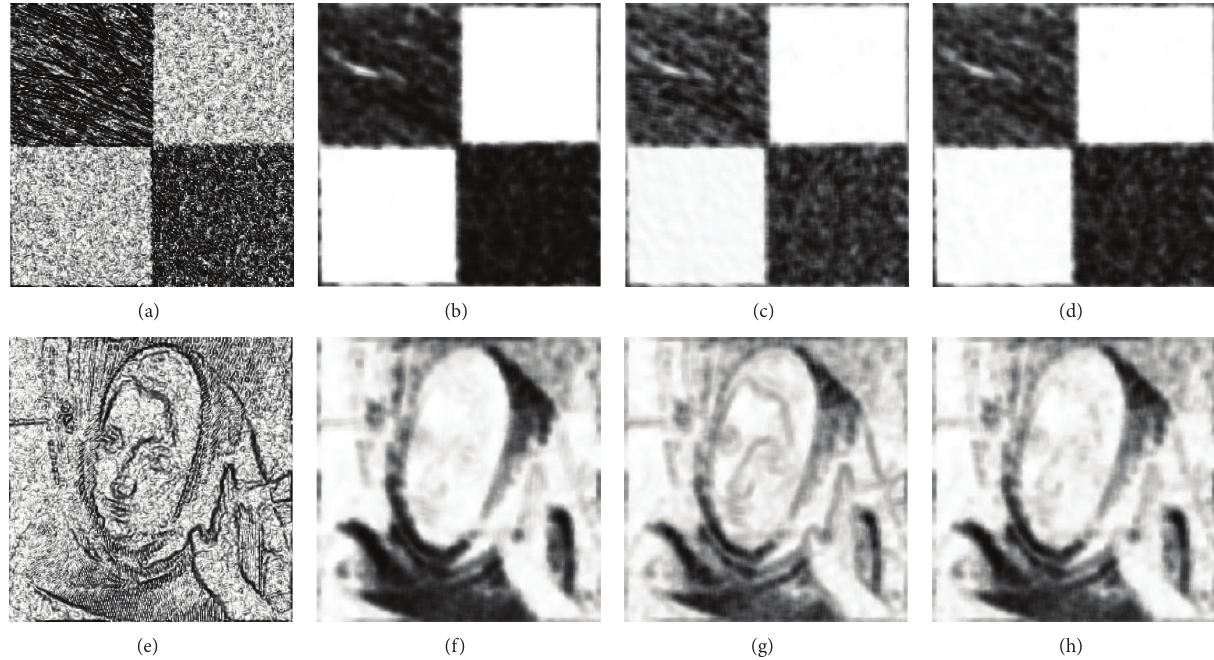
Figure 10: Final values of the regularization parameters in the proposed models and weighting functions in the hybrid model corresponding to Figures 4(d)–4(f) and 6(d)–6(f). (a) 𝑔 in the hybrid model, (b) 𝑔 ∗ in Model 1, (c) 𝑔 ∗ 1 in Model 2, (d) 𝑔 ∗ 2 in Model 2, (e) 𝑔 in the hybrid model, (f) 𝑔 ∗ in Model 1, (g) 𝑔 ∗ 1 in Model 2, and (h) 𝑔 ∗ 2 in Model